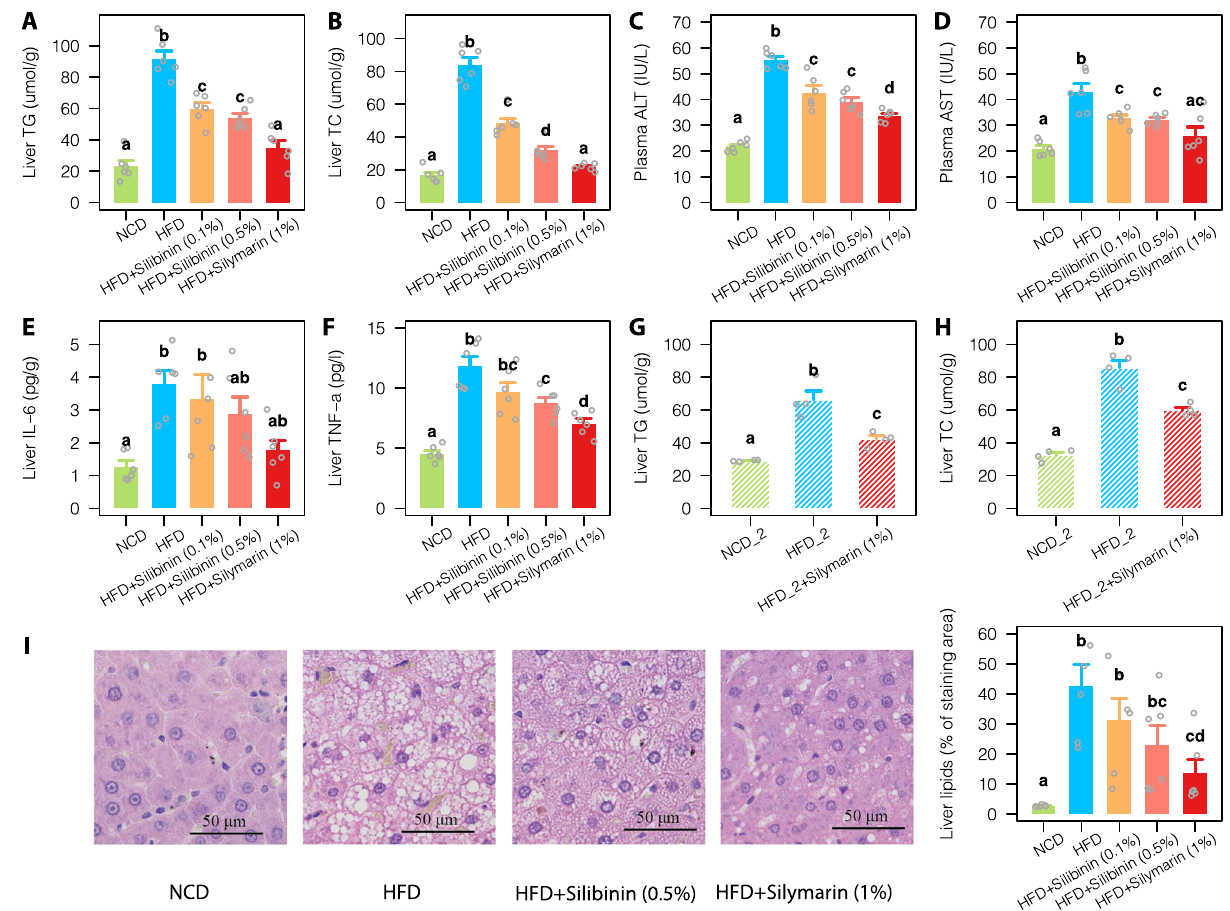
Fig. 1 | Improvement of liver lipid metabolism in rats upon silymarin/silibinin treatment for12weeks. Levels of liverTG( A )and TC( B );levelsofplasmaALT( C ) and AST ( D ); and levels of liver IL-6 ( E ) and TNF- α ( F ) in all fi ve treatment groups. Changes of Liver TG ( G ) and TC ( H ) from a second replicate experiment. I Representative microphotograph of hematoxylin and eosin (H&E) staining and quanti fi cation of liver lipids. Values were shown as mean ± S.E.M. Groups labeled